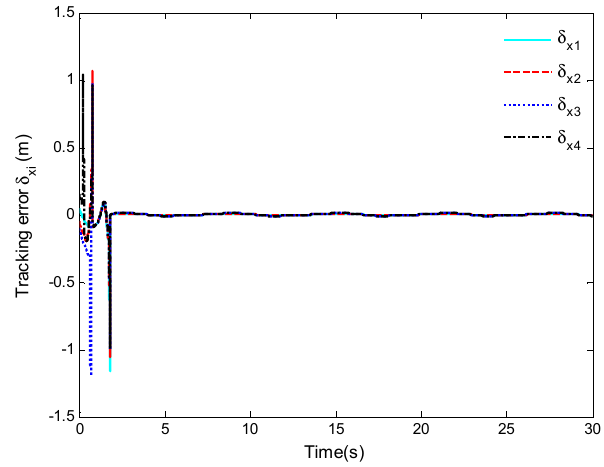
Figure 4. The curves of the position tracking error δ xi